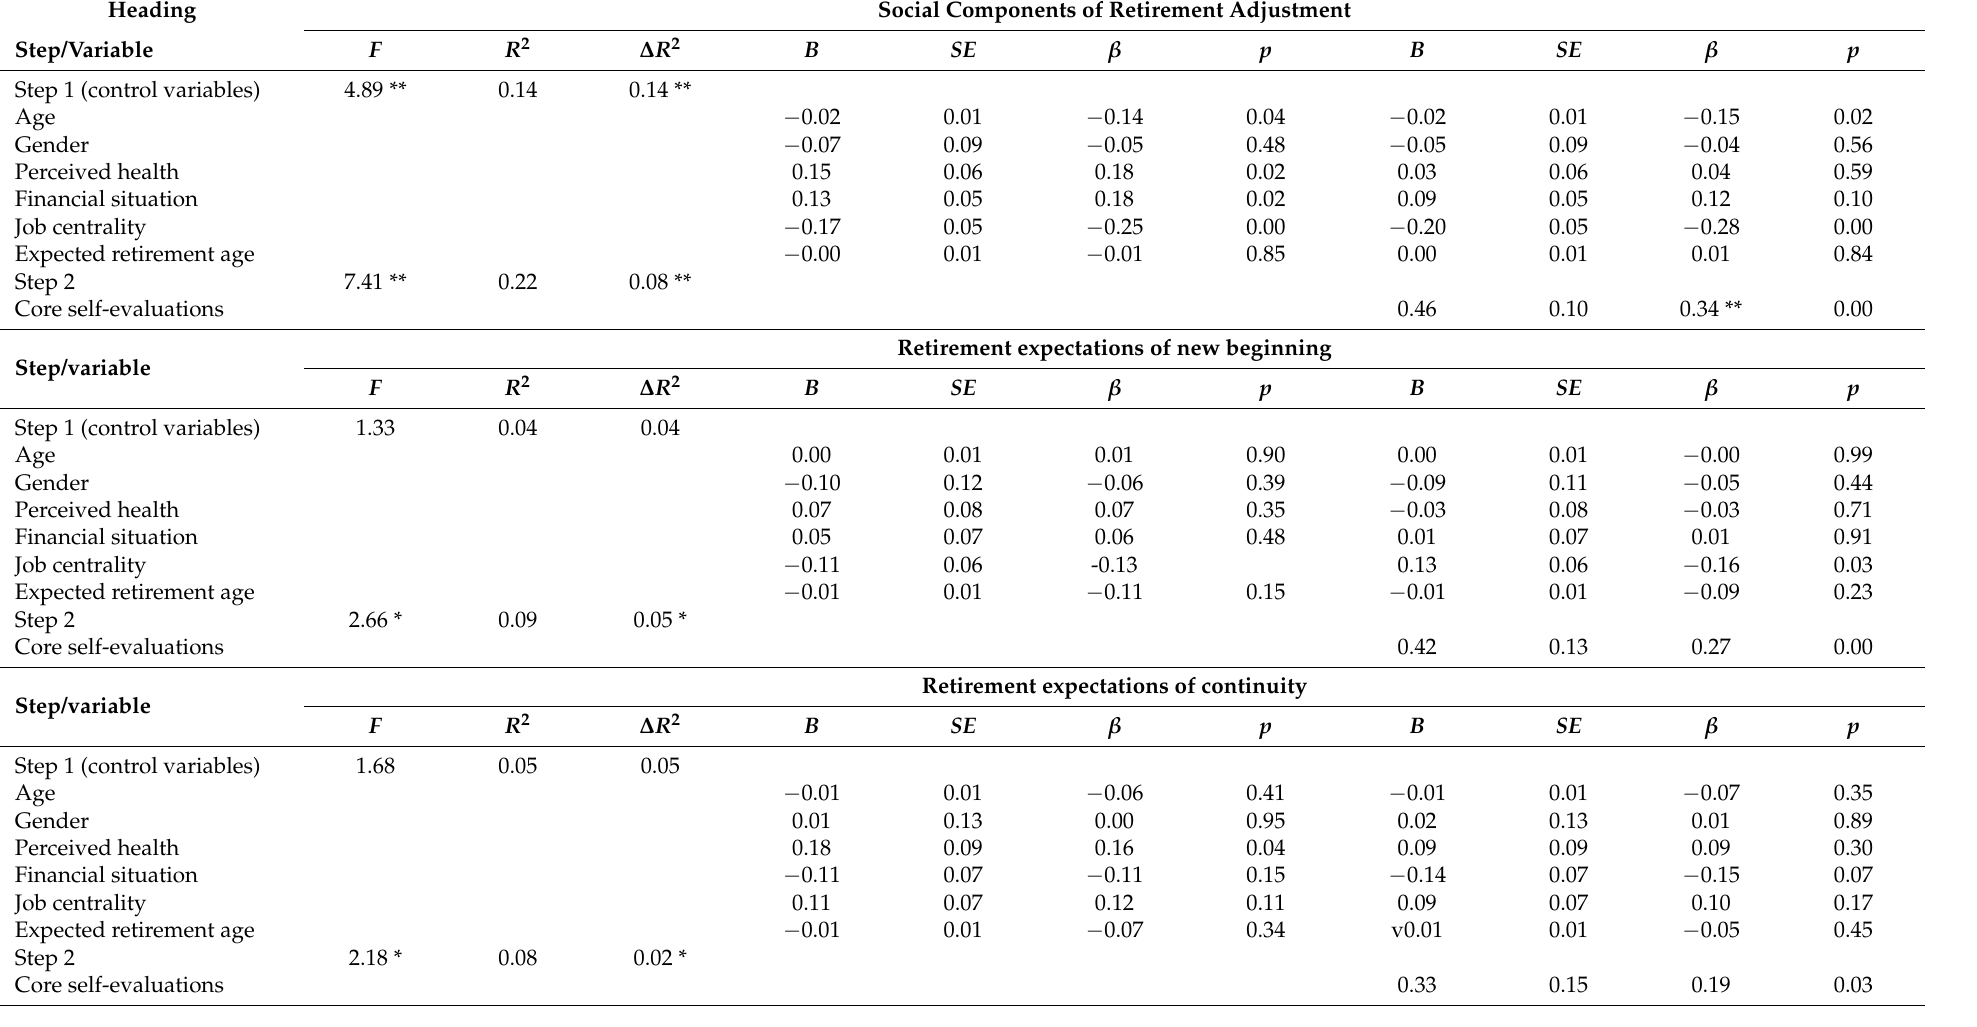
Table 2. Results of the hierarchical multiple regression analysis ( n =